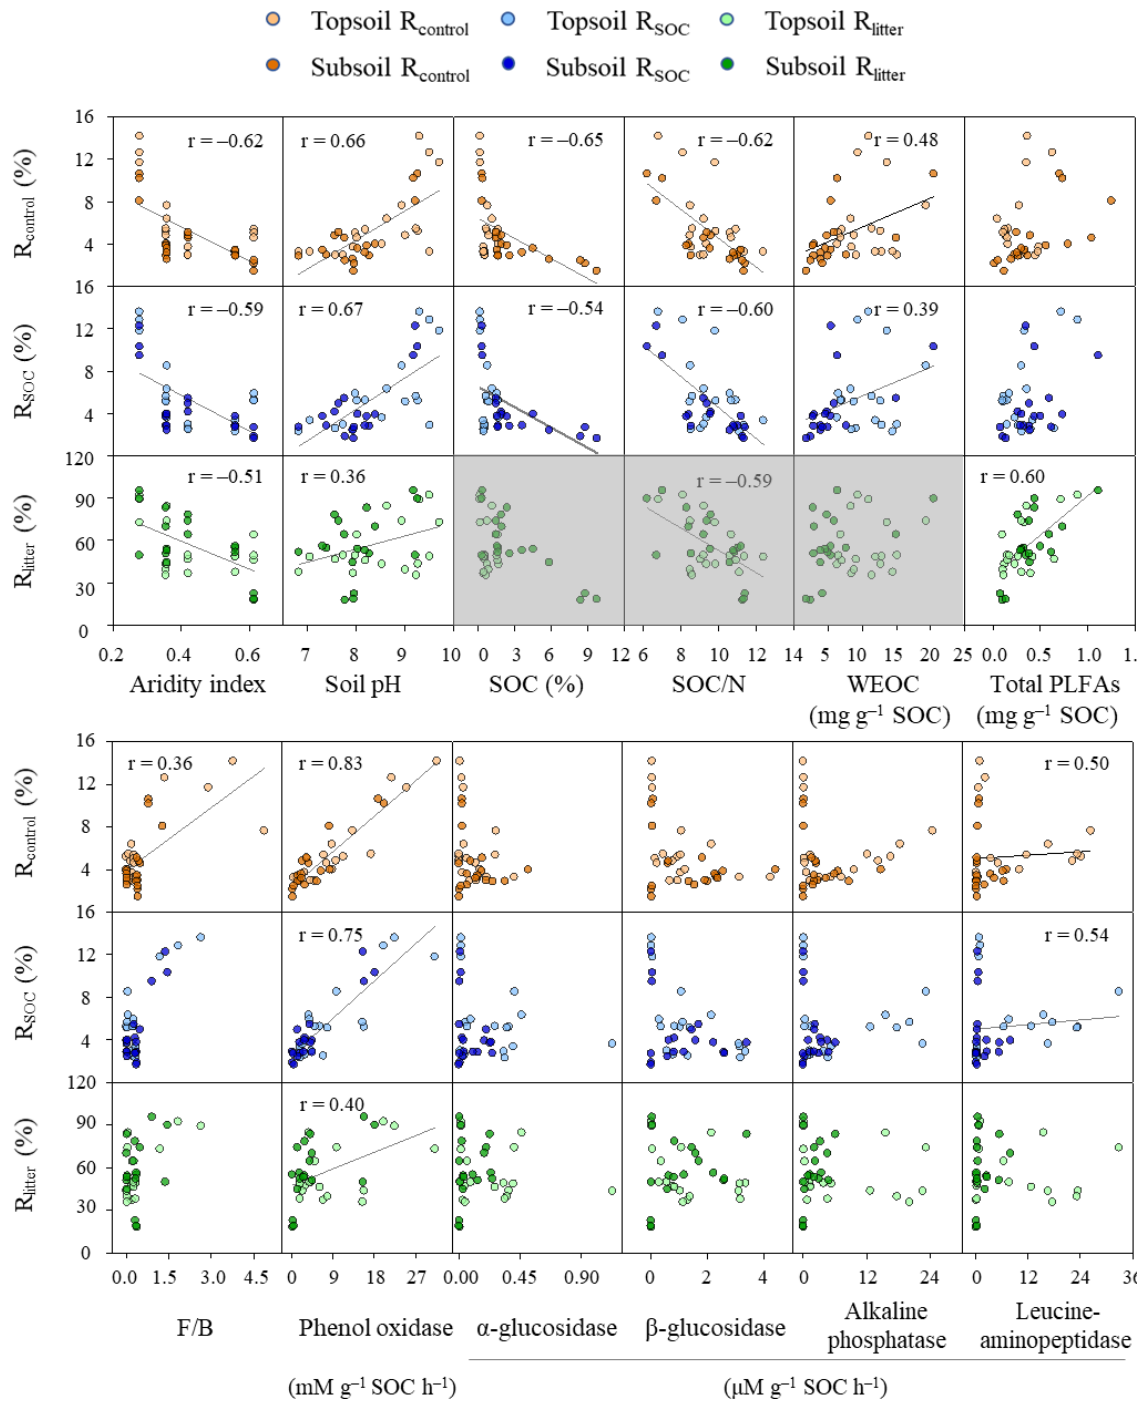
Figure 2. Relationships between the mineralization potential of substrates and key environmental variables. R control and R SOC refer to the mineralization potential of soil organic carbon (SOC) in the control and leaf-amended treatments, respectively, while R litter refers to the mineralization potential of leaf litter. N: nitrogen; WEOC: water-extractable organic carbon; F / B: ratios of fungal to bacterial PLFAs; PLFAs: phospholipid fatty acids. Field replicates are shown as individual data points. Black lines represent significant Spearman correlations for non-normally distributed data or Pearson correlations for normally distributed data (i.e., between pH and R litter ; p < 0 . 05). Three boxes of R litter are shaded in grey because the examined soil properties do not describe litter quality and hence should not be